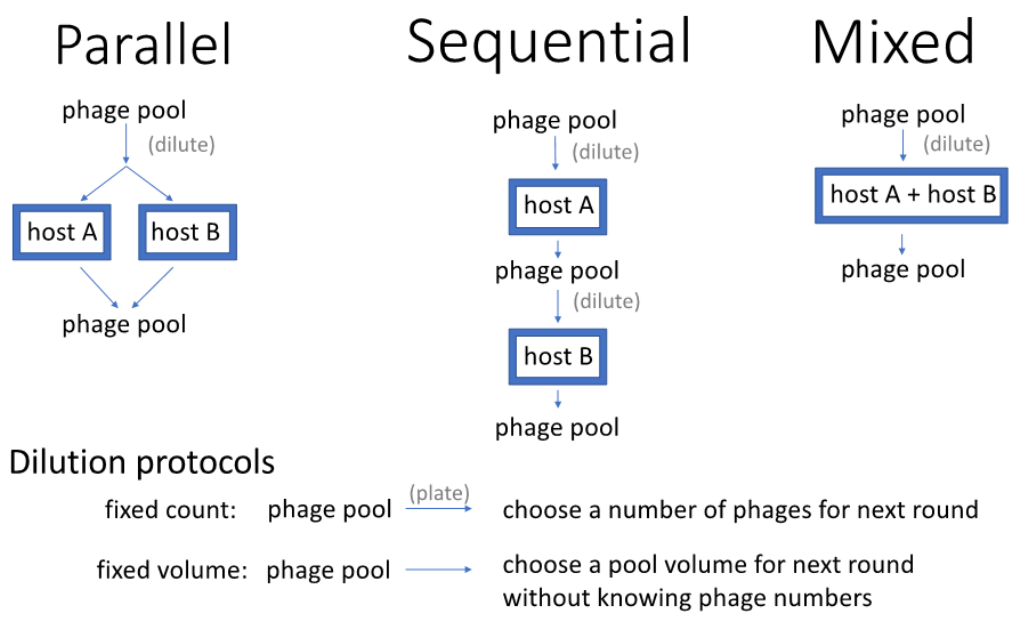
Figure 1. Three alternative host-presentation protocols (Parallel, Sequential, Mixed) differ in how phages are distributed to two different hosts on which growth is desired. Each box around a host type (A or B or both) represents a separate culture of hosts to which phage are added and grown. The figure illustrates a single cycle, but typically a procedure is carried out for several cycles. The figure also includes two dilution protocols that may be used when distributing phages into the next cycle (fixed count, fixed volume).